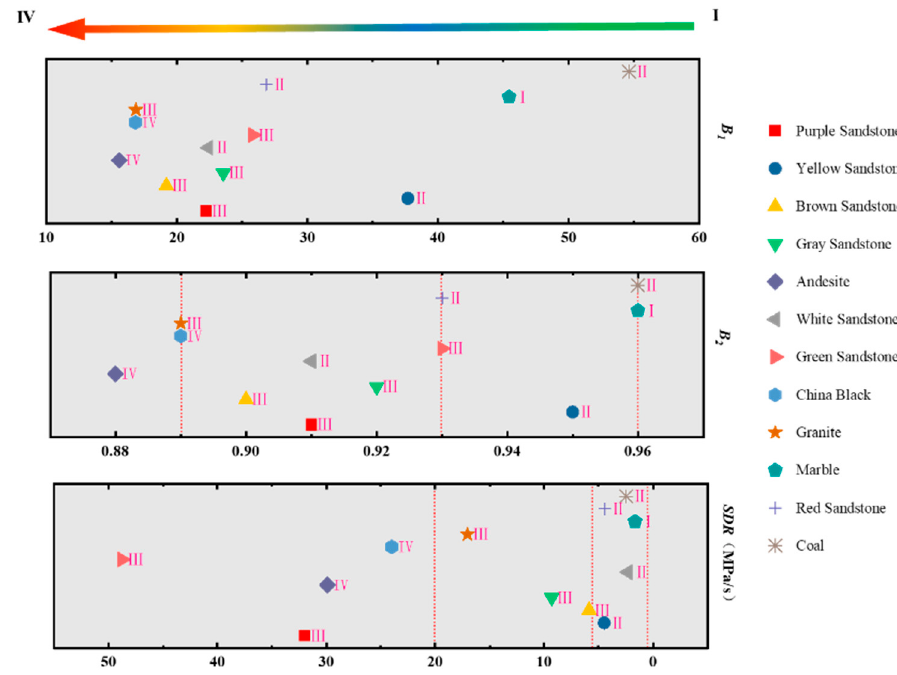
Figure 10. Classi fi cation criteria of the rockburst proneness of rocks in this study. Figure 10. Classification criteria of the rockburst proneness of rocks in this